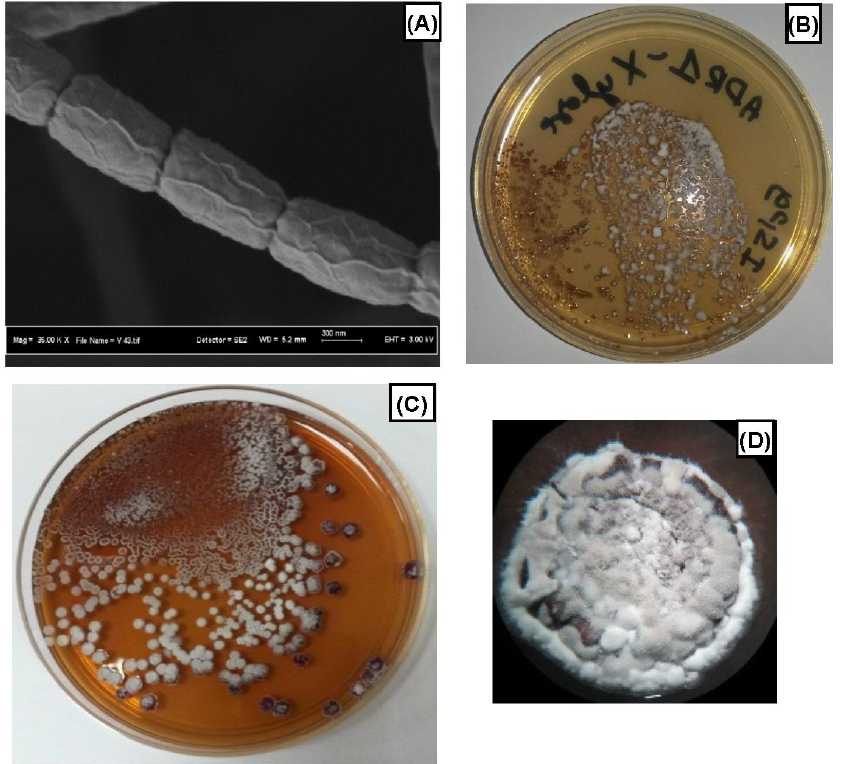
Figure 1. ( A ) Scanning electron micrograph of Streptomyces sp. ADR1 strain. ( B ) Streptomyces sp.